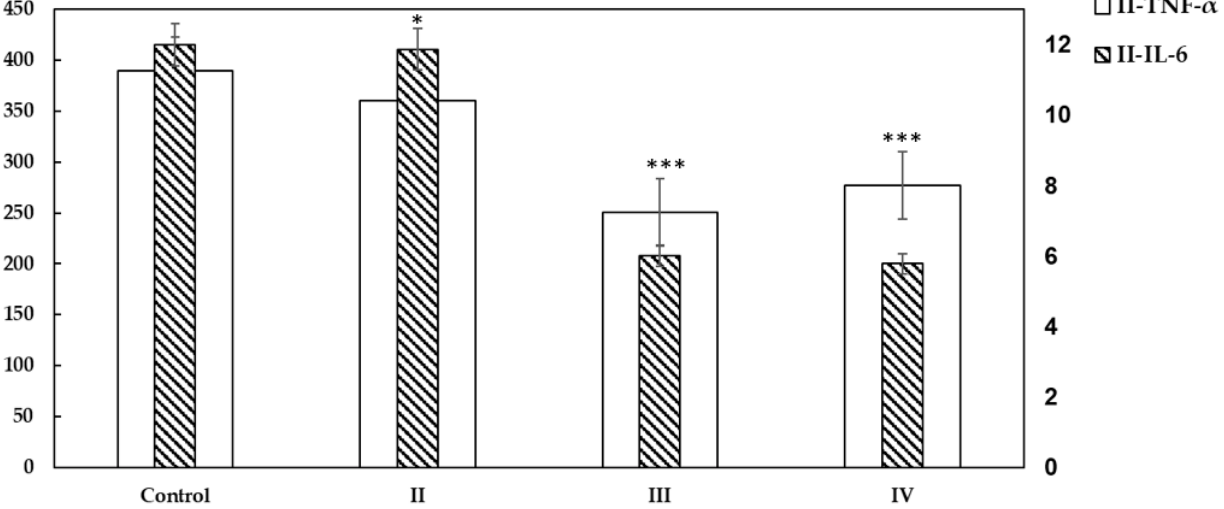
Figure 5. Protein expression of IL-6 and TNF- α in MCF-7 tumor xenografts. All experiments were repeated six times and data are presented as mean ± SD with error bars (n = 6), * p < 0.05; *** p < 0.001. An unpaired Student t-test was conducted in comparison to the control.